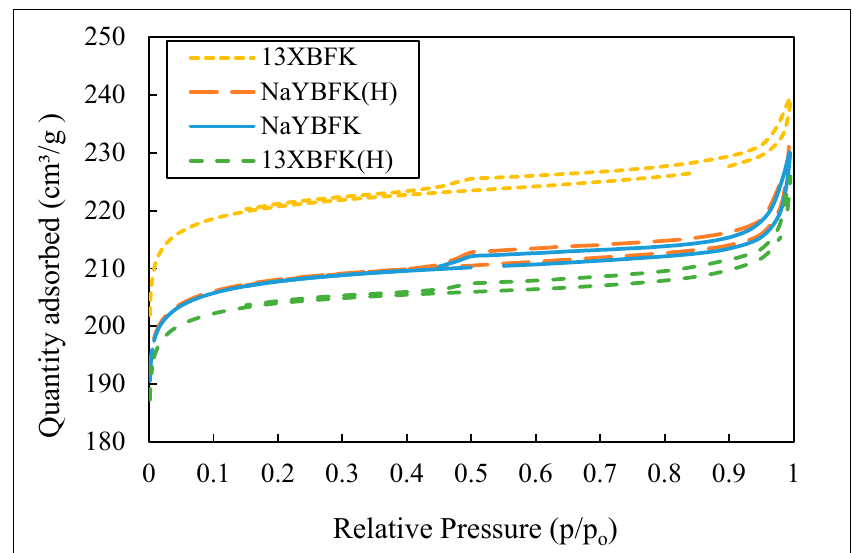
Figure 2. Nitrogen sorption isotherms at 77 K on zeolite samples. Table 2. Textural parameters of 13XBFK, 13XBFK(H), NaYBFK and